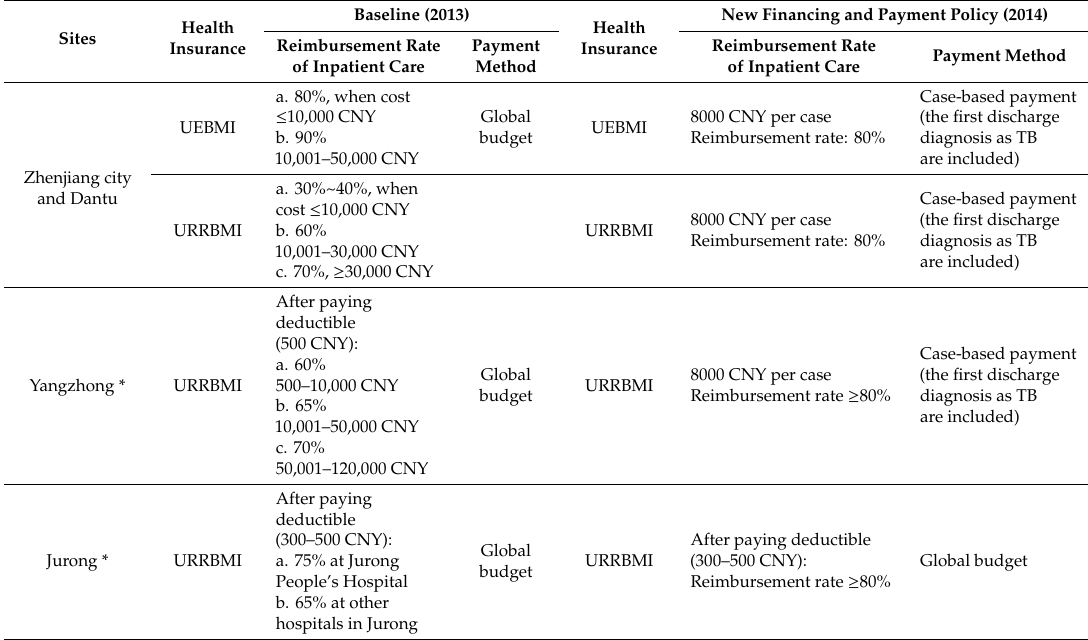
Table 1. Health insurance reimbursement policies and payment method for TB inpatient care before and after the intervention in